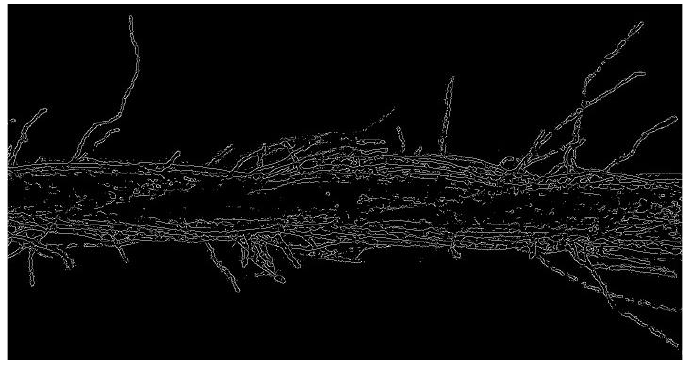
Figure 36. Insulated contours of the textile yarn.